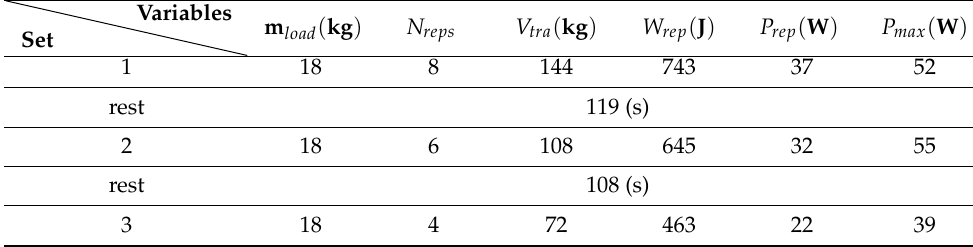
Table 6. Exercise prescription variables for biceps